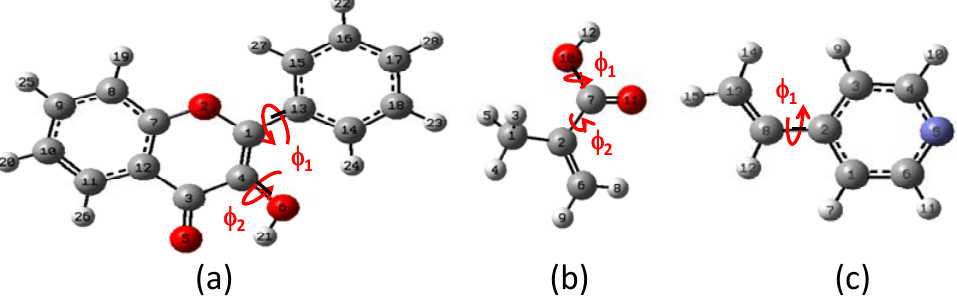
Figure 1. Torsion angles φ 4-vinylpyridine (4VPy).